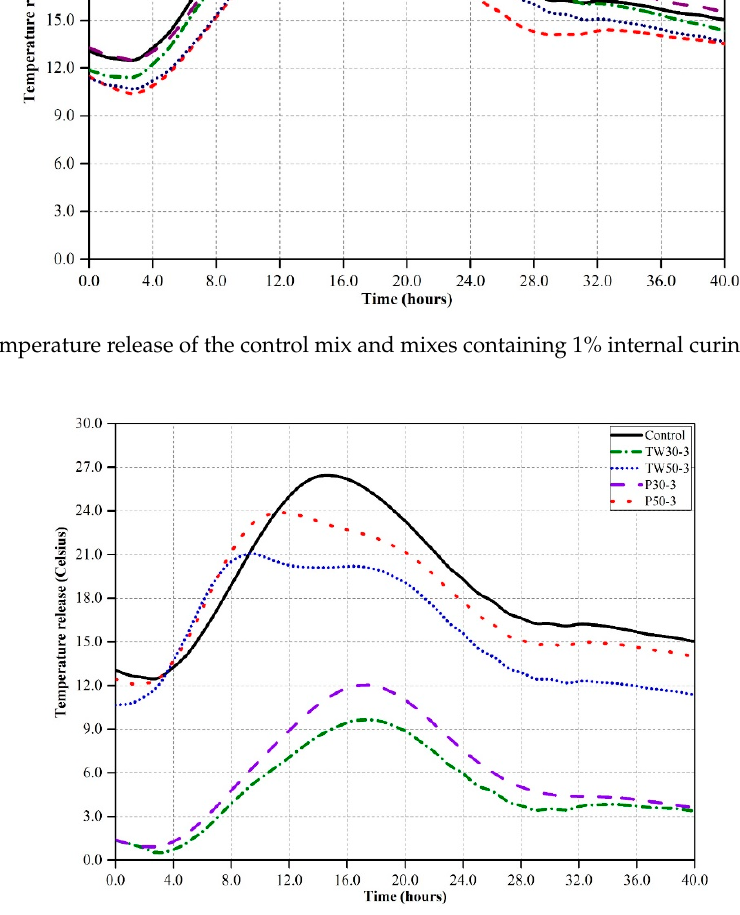
Figure 2. Temperature release of the control mix and mixes containing 1% internal curing agents (ICA) over 40 h.